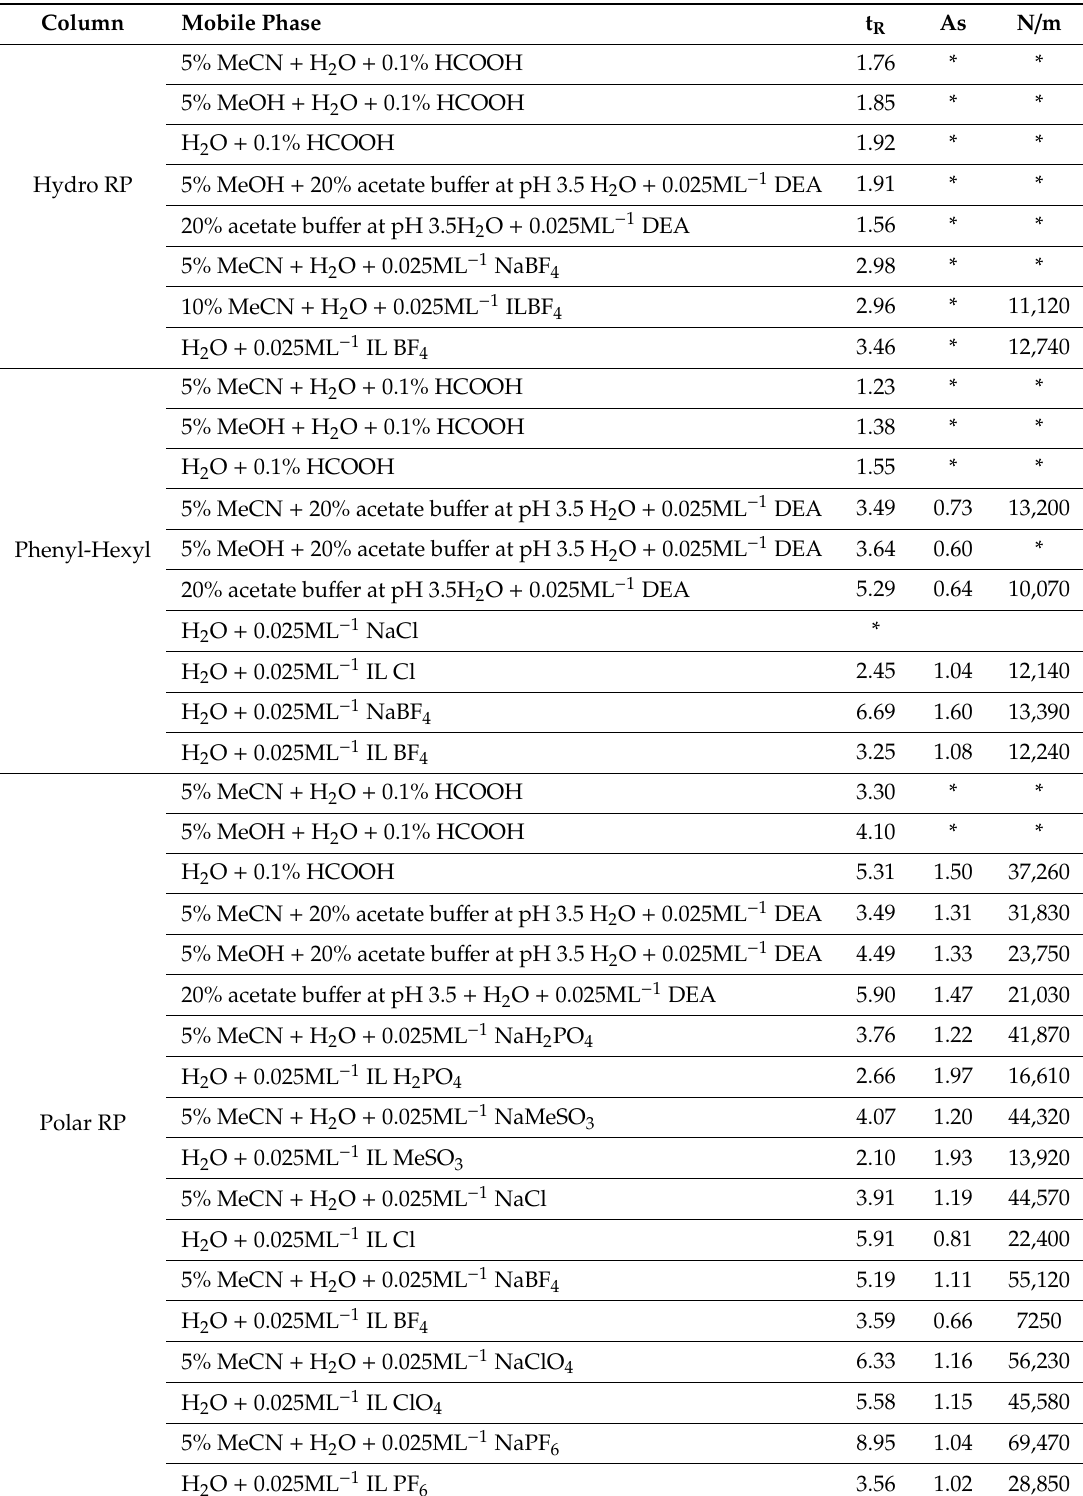
Table 2. Retention time (t R ), asymmetry factor (As) and theoretical plate number per meter (N / m) values obtained for cytisine at concentration 10 µ g mL − 1 on various columns with di ff erent mobile phases; * fuzzy